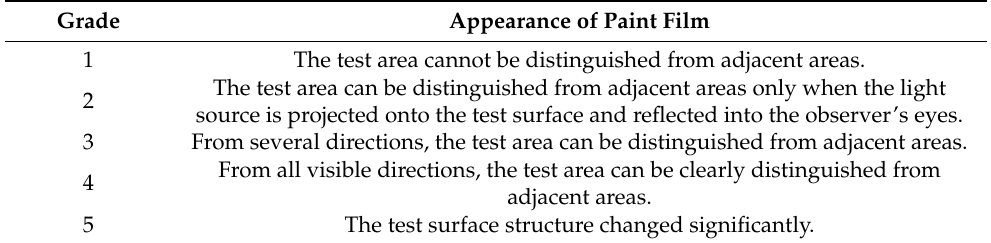
Table 1. Classification of liquid resistance of the paint film on the wood surface.